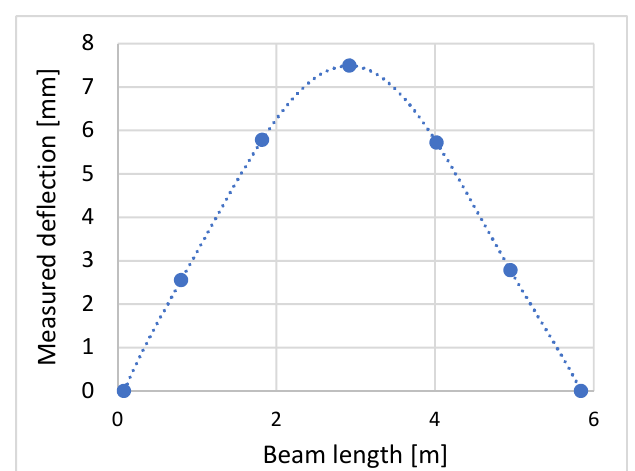
Figure 12. Simplified shape of the deflected beam between supports.